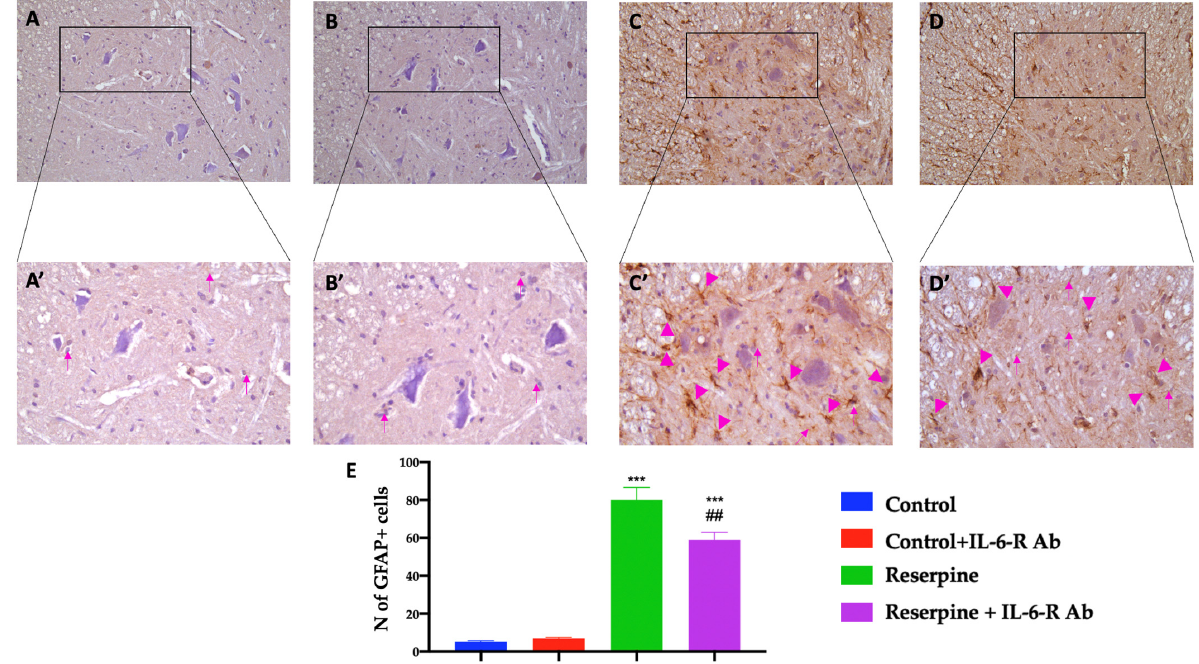
Figure 6. Effects of IL-6-R Ab on astrocyte activation: Immunohistochemical analysis of GFAP expressions: ( A , A’ ) control, ( B , B’ ) control + IL-6-R Ab, ( C , C’ ) reserpine, ( D , D’ ) reserpine + IL-6-R Ab, graphical quantification of GFAP expressions. Non-reactive glial cells are marked with an arrow, reactive glial cells are marked with an arrowhead, ( E ) N of GFAP + cells.